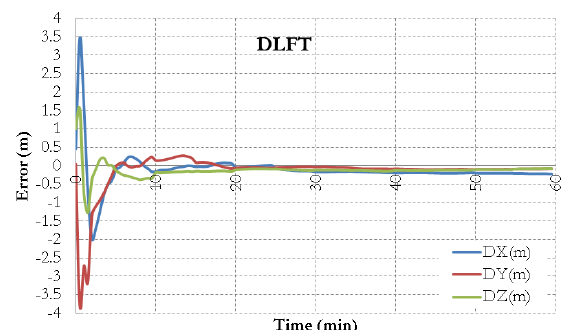
Figure 6. Dual-frequency GPS (L1/L2)/Galileo (E1/E5b)